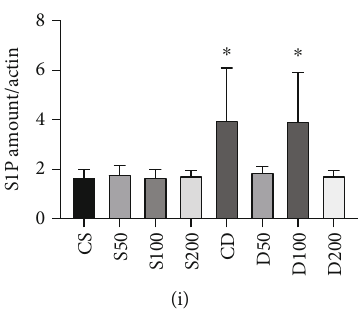
Figure 3: (a) Comparison of the fi rst day S1P level of blood of K6PC-5 treated and nontreated rats. (b) Comparison of last day S1P level of blood of K6PC-5 treated and nontreated rats ( ∗ p < 0 : 05 ). (c) Comparison of last day S1P level of cardiac tissue of K6PC-5 treated and nontreated rats ( ∗ p < 0 : 05 ). (d) Comparison of fi rst day S1P level of blood of healthy and diabetic rats. (e) Comparison of last day S1P level of blood of healthy and diabetic rats ( ∗ p < 0 : 05 ). (f) Comparison of last day S1P level of cardiac tissue of healthy and diabetic rats ( ∗ p < 0 : 05 ). (g) Comparison of blood samples ’ S1P level of the fi rst day of CS, S50, S100, S200, CD, D50, D100, and D200 groups. (h) Comparison of blood samples ’ S1P level of last day of CS, S50, S100, S200, CD, D50, D100, and D200 groups ( ∗ p < 0 : 001 ). (i) Comparison of cardiac tissue samples ’ S1P level of last day of CS, S50, S100, S200, CD, D50, D100, and D200 groups ( ∗ p < 0 : 001